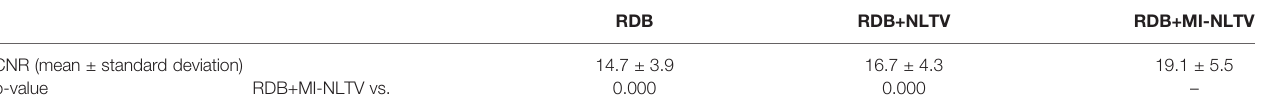
TABLE 5 | CNR comparisons in the CBCT image generated by three RDB-based reconstruction algorithms using low-dose projection data of the anthropomorphic phantom.